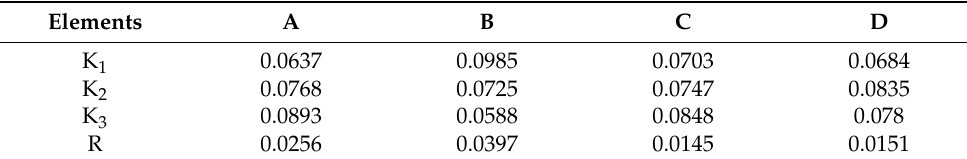
Table 5. Range analysis of thermal conductivity. Elements